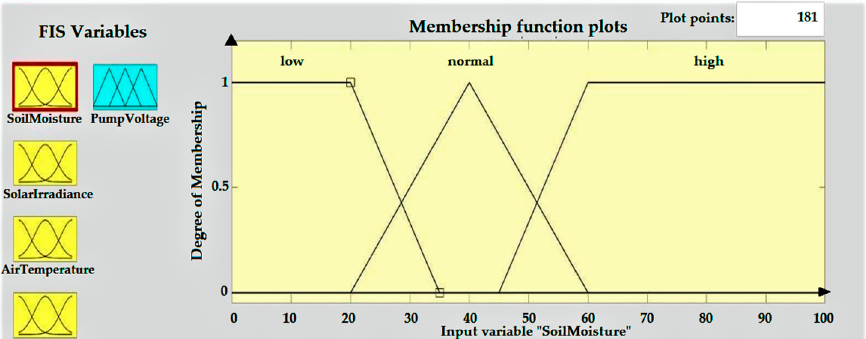
Figure 3. Soil moisture membership function plot.